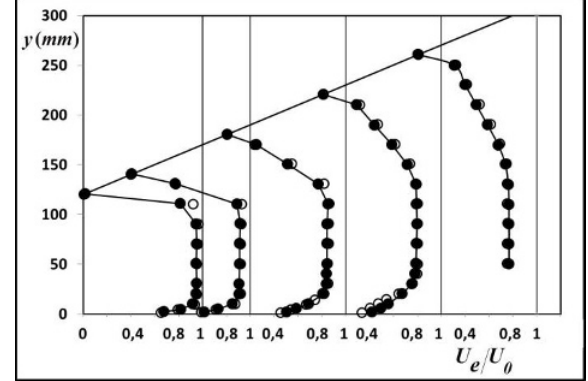
Fig. 4. Mean velocity profiles across the diverging 2D-channel. (symbols as in figure